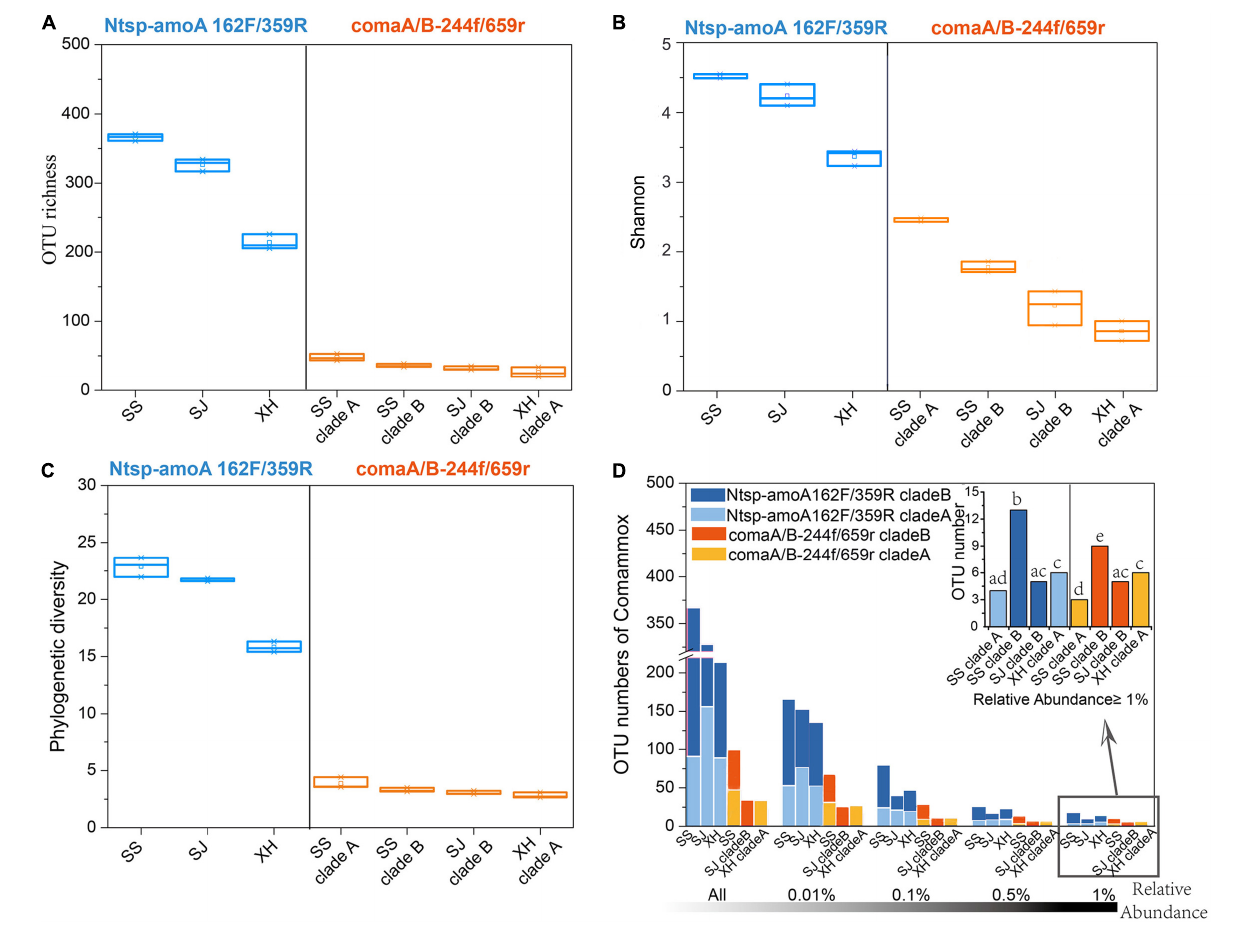
FIGURE 3 | (A) OTU richness, (B) Shannon index, and (C) phylogenetic diversity of comammox communities in three wetland soils using primer Ntsp-amoA 162F/359R (blue) and comaA/B-244f/659r (orange). (D) OTU numbers of comammox amoA gene sequences amplified by primer Ntsp-amoA 162F/359R (blue) and comaA/B-244f/659r (orange) with RA greater than 0.01, 0.1, 0.5, and 1% in the total reads of each sample. A bar graph on the top right indicated the difference between OTU numbers of the dominant OTUs with RA ≥ 1.0% amplified by two primer sets. Bars do not share the same letter considered to be different ( P <